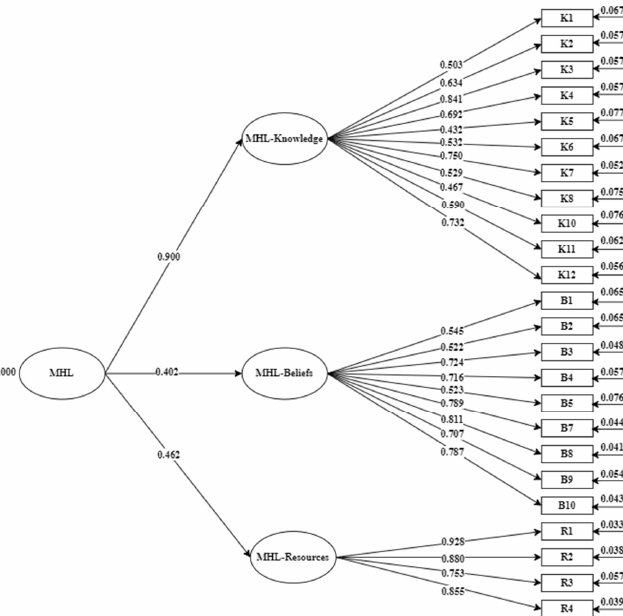
Figure 1. Second-order model with standardized factor loading on MHL-Knowledge, MHL-Beliefs, and MHL-Resources ( n = 320).